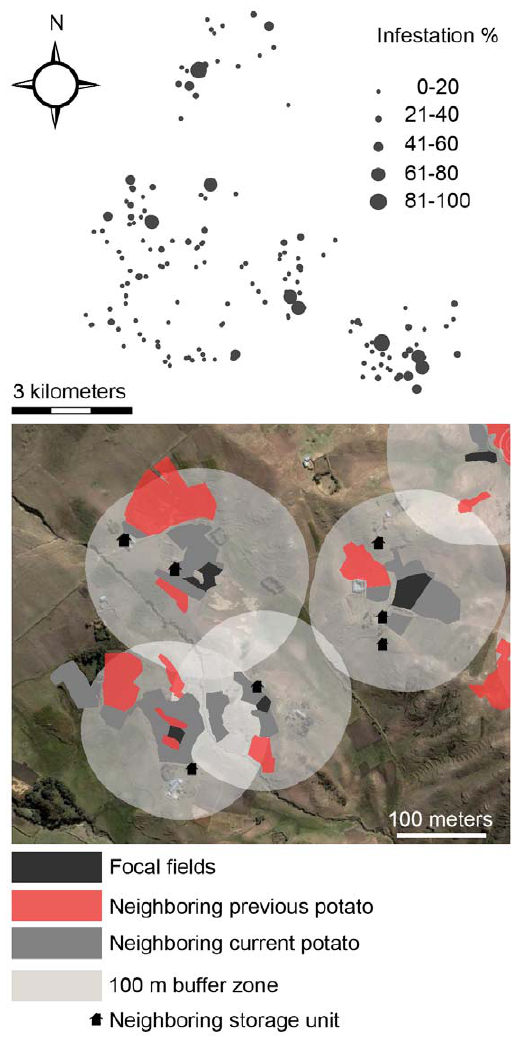
Figure 2. Landscape in the study area in Huancavelica, Peru. (Top) Distribution of study fields showing percentage infestation by Andean potato weevils ( Premnotrypes spp.). (Bottom) Representative study fields showing landscape predictors of percentage infestations by Andean potato weevils.